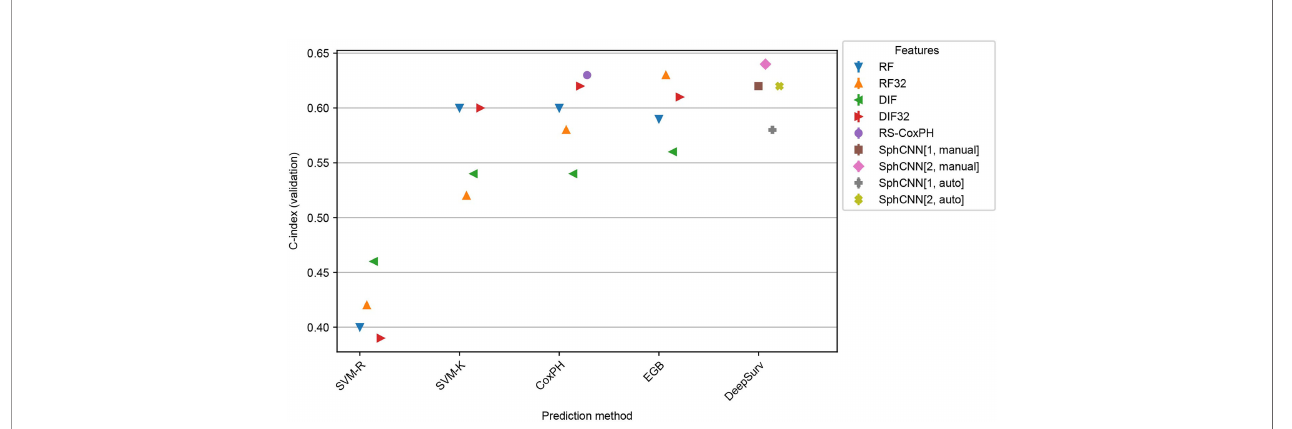
FIGURE 7 | Performance comparison for the models trained on Lung1 and evaluated on Lung3. We used the prediction methods and features as labelled in Figure 6 .